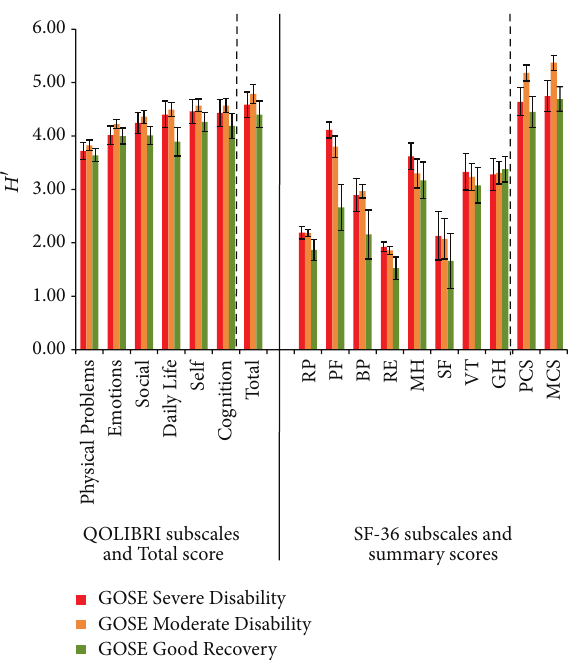
Figure 4: Shannon indices 𝐻 󸀠 (confidence intervals 95%) of all QOLIBRI and SF-36 subscales, QOLIBRI Total score and MCS and PCS for the correlate GOSE